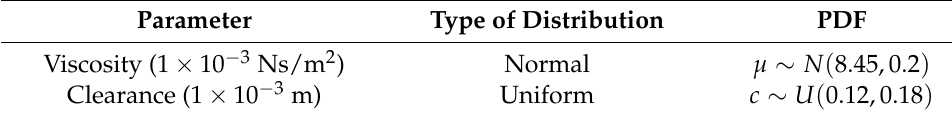
Table 2. Details of distribution of random parameters.